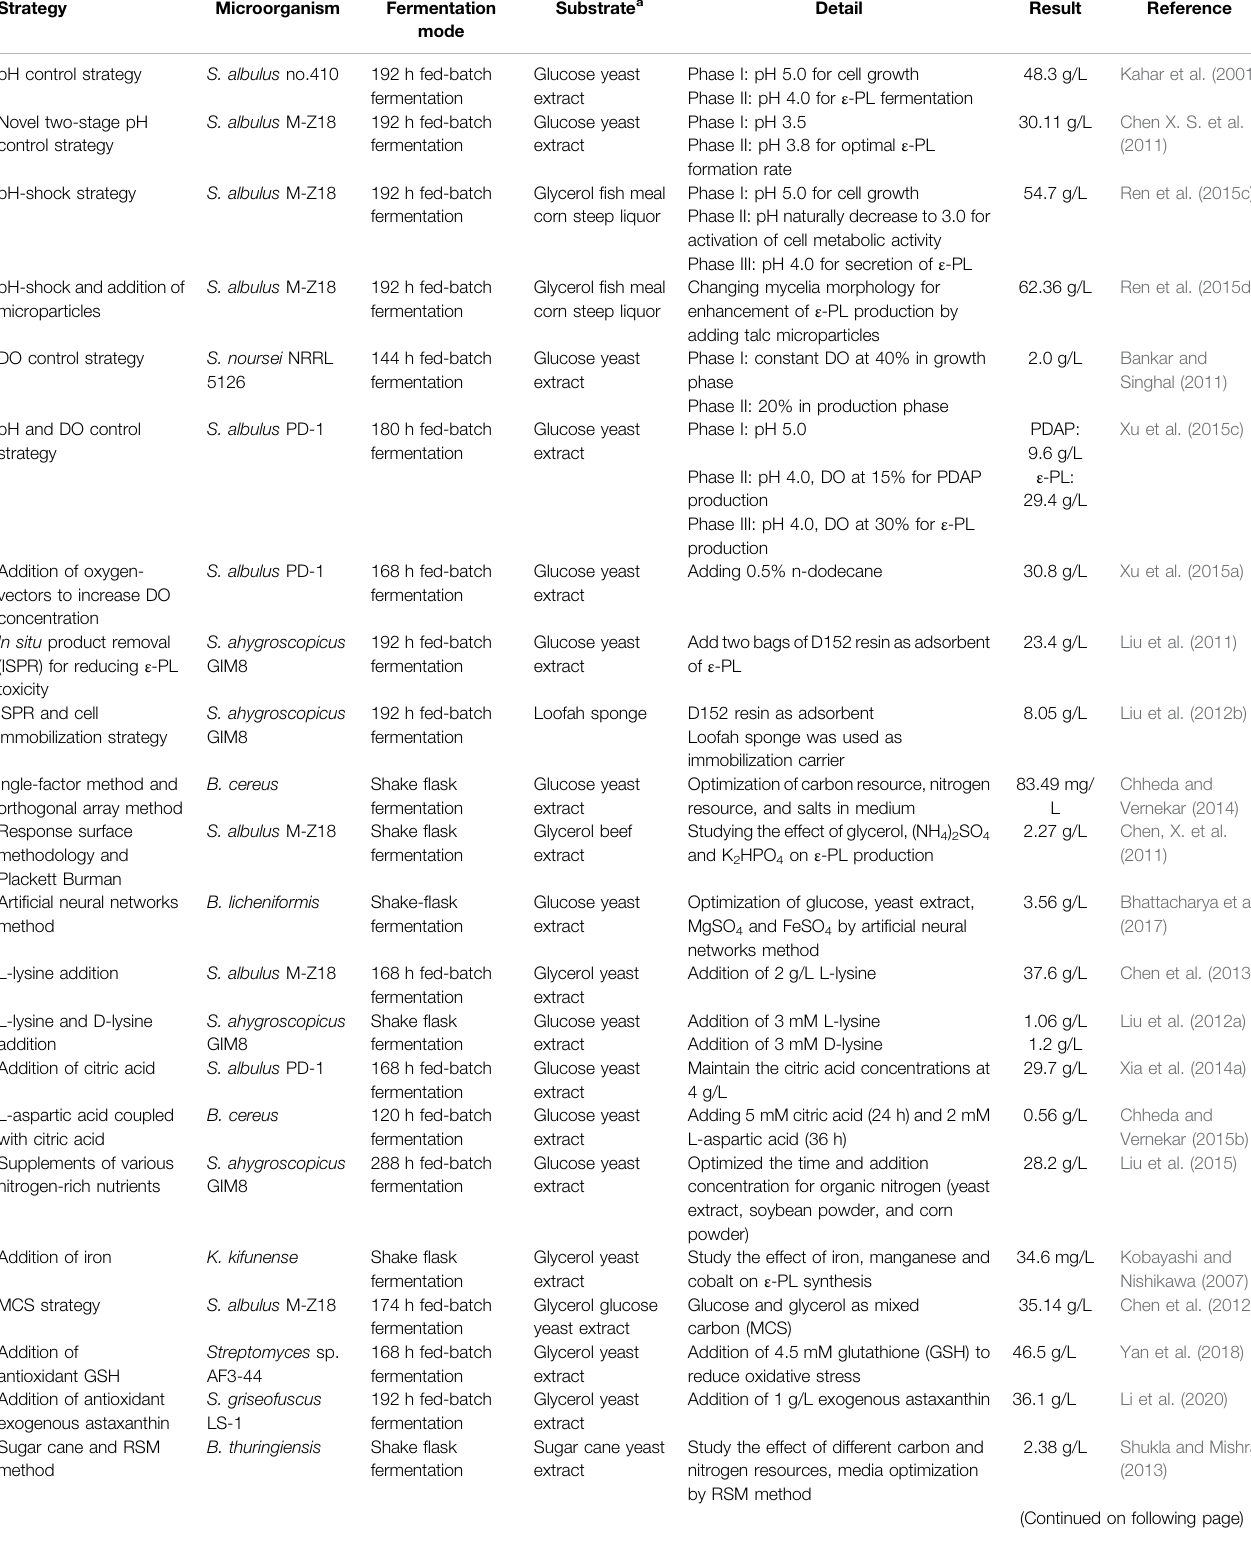
TABLE 2 | Summary of the process engineering strategies on ε -PL